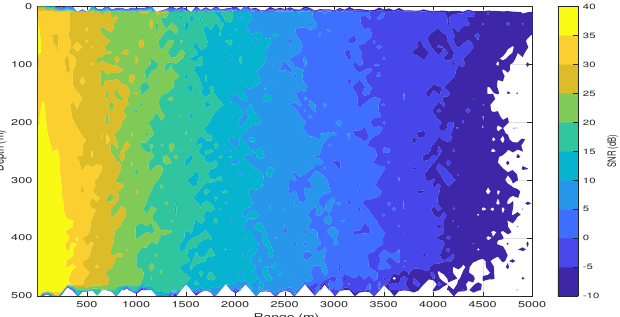
Figure 6. SNR as a function of range and depth for the source at 480 m depth, source level: 170 dB re 1 µ Pa at 1 m, 24 KHz centre frequency and 7.2 KHz